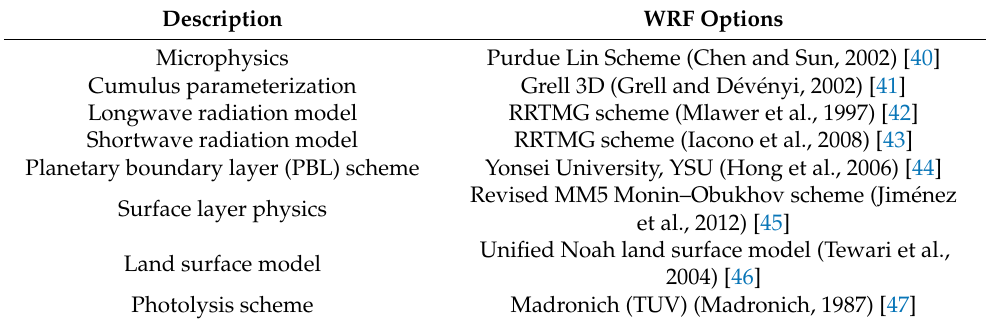
Table 2. Details of parameterization schemes used in the WRF-Chem